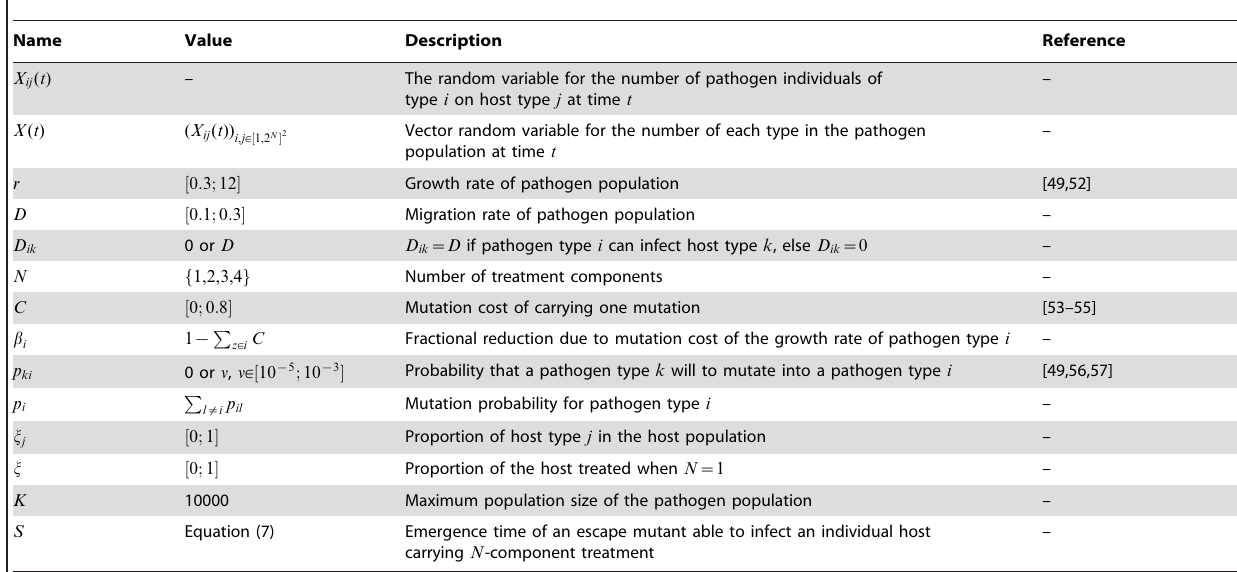
Table 1. Definition of variables and parameters used to model pathogen adaptive